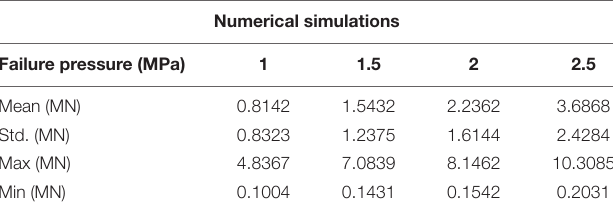
TABLE 5 | Comparison of the ice forces in the simulations with different failure pressures.